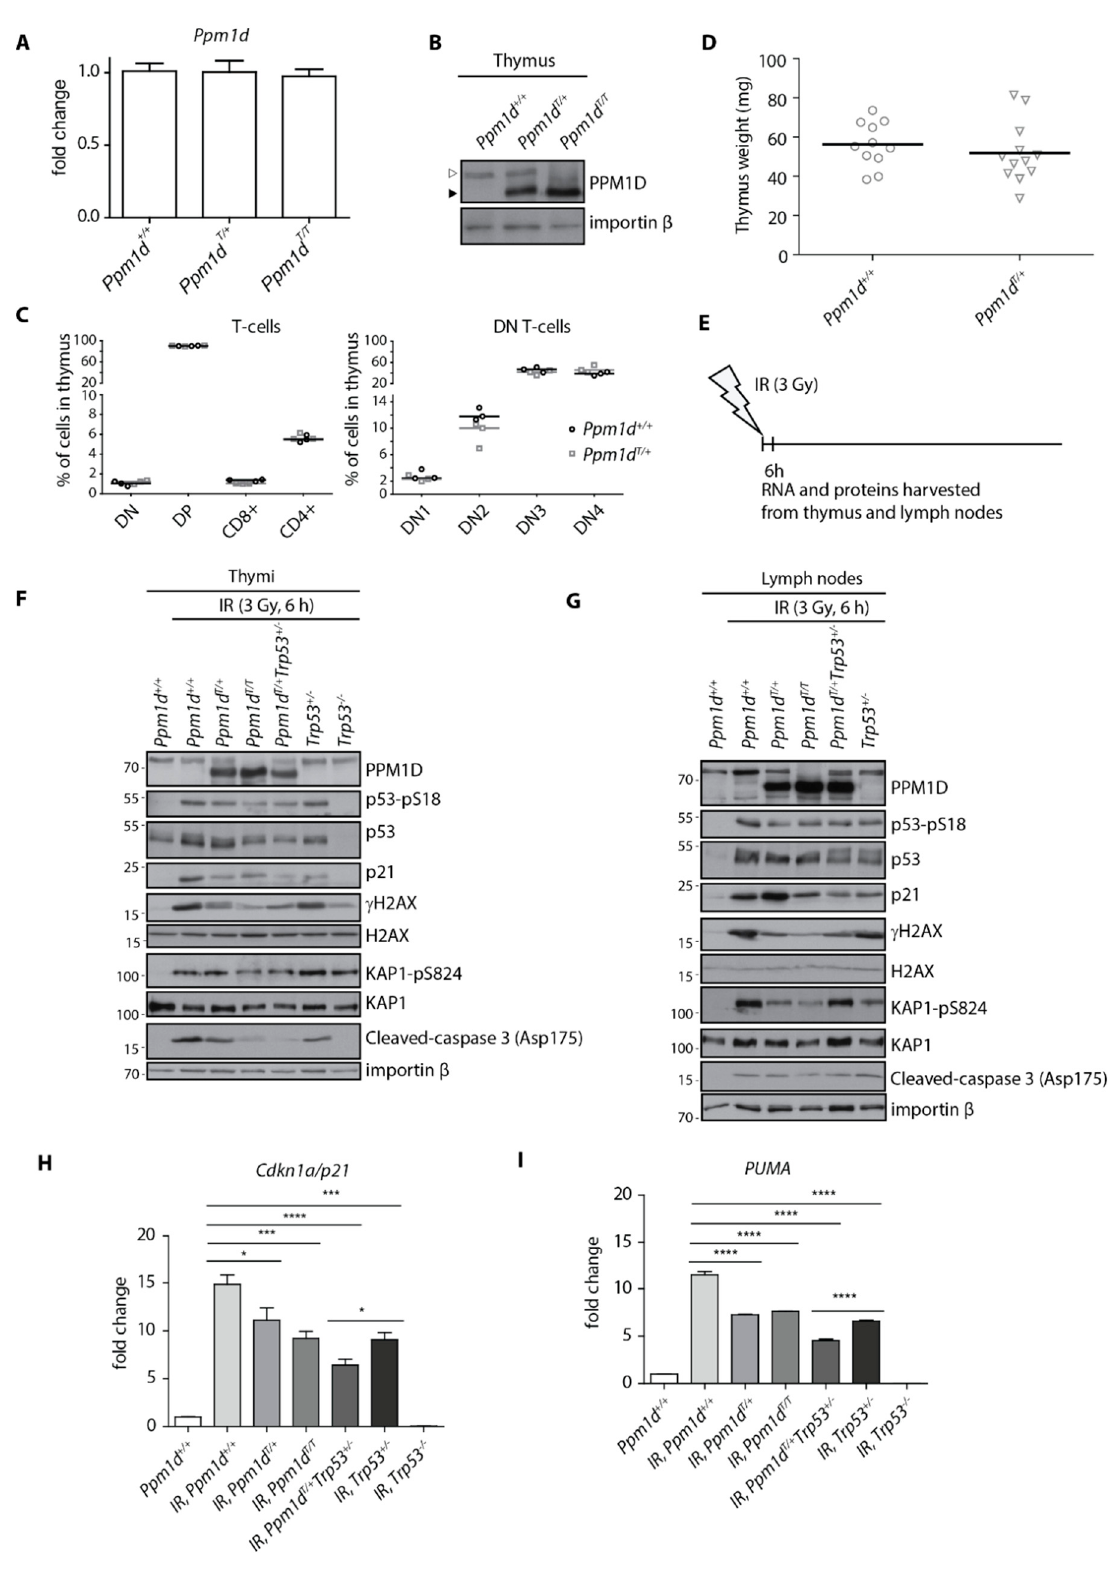
Figure 1. Truncated PPM1D impairs DNA damage response in mouse thymus. Expression of PPM1D mRNA was analyzed by RT-qPCR in the thymi of Ppm1d +/+ , Ppm1d T/+ and Ppm1d T/T mice and was normalized to GAPDH ( n = 3) ( A ). Thymi from mice of indicated genotypes were lysed and proteins were separated by SDS-PAGE. Samples were probed with antibody against PPM1D and importin- β as a loading control. The empty and full arrowheads indicate the position of the full-length and the C-terminally truncated PPM1D, respectively. ( B ). Cells from thymi from Ppm1d +/+ and Ppm1d T/+ mice were analyzed by flow cytometry. Plotted are the counts of the indicated populations as follows: